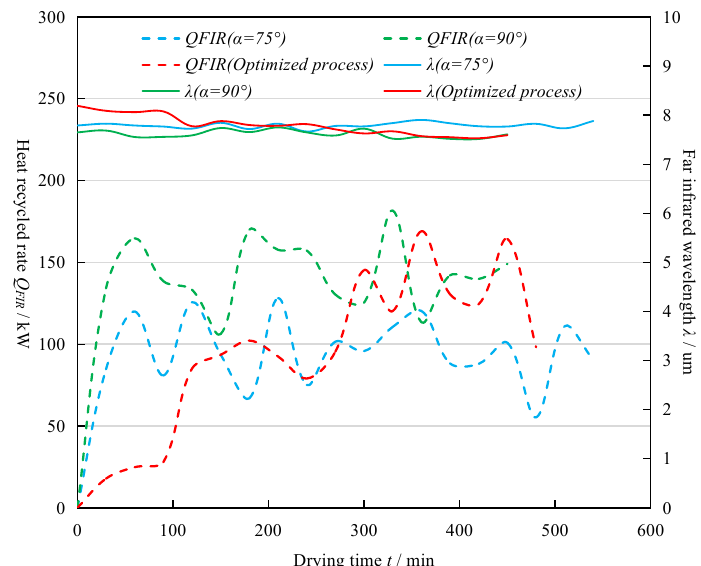
Figure 5. The wavelength and the heat-recycled performance of the RA under different drying processes.